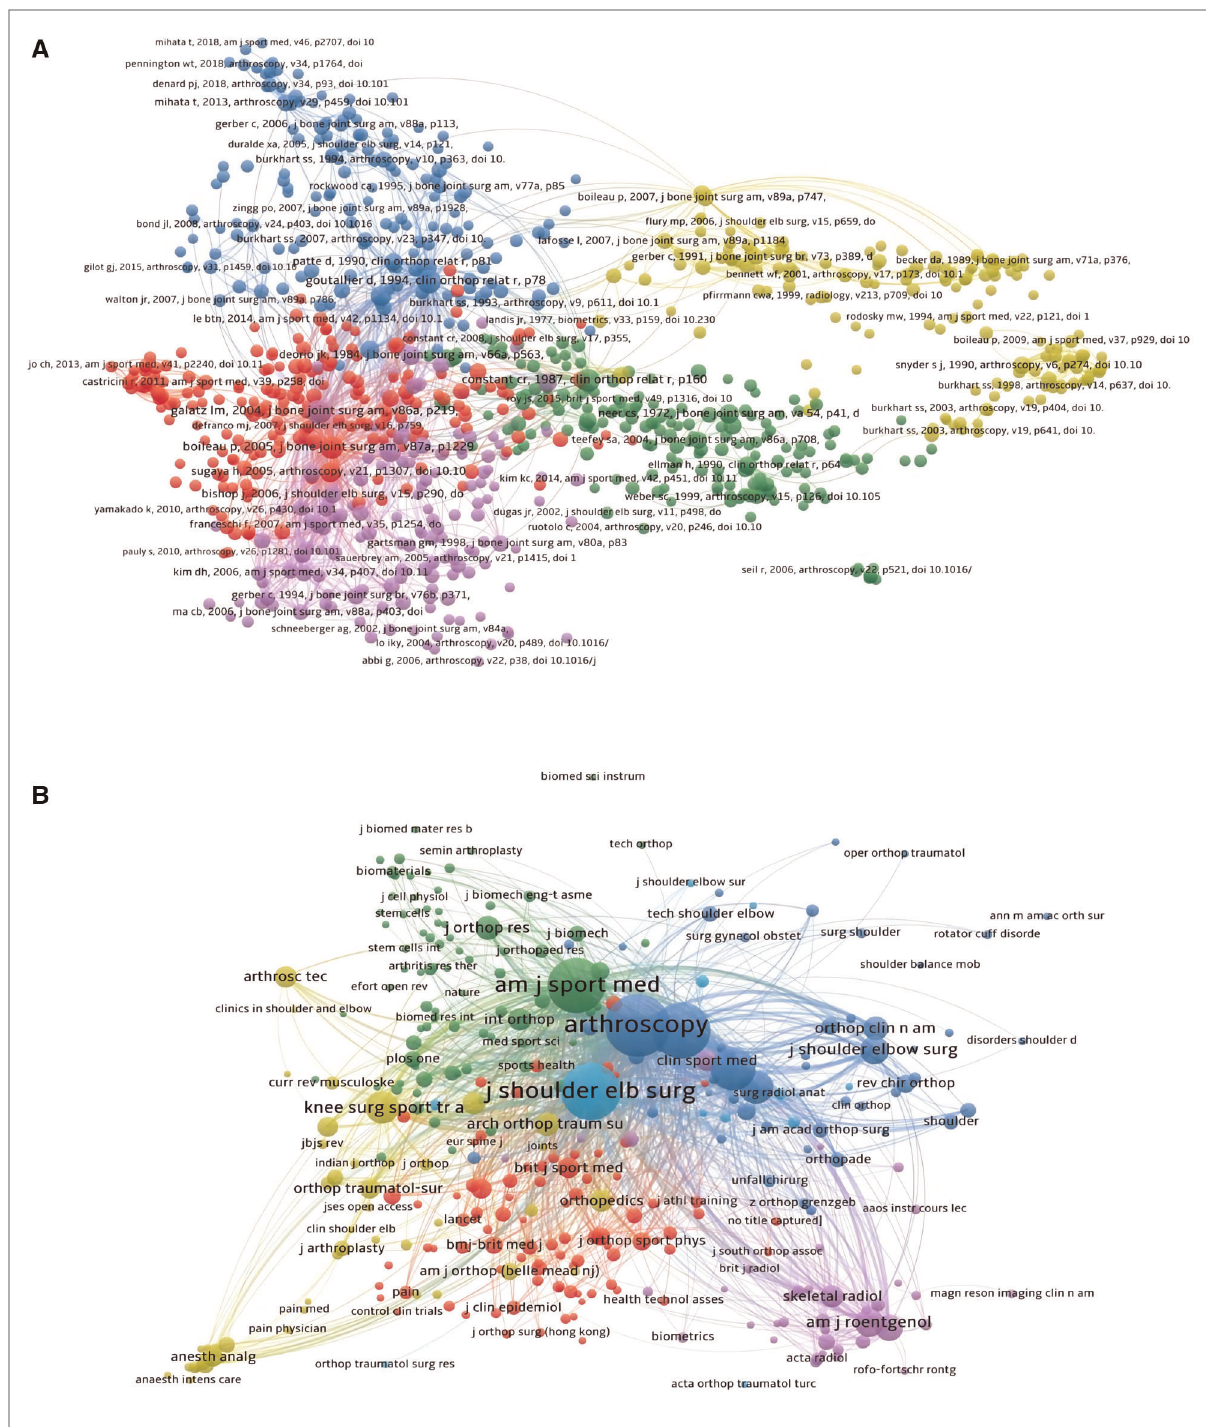
FIGURE 10 Co-citation analysis of publications and journals (analysis based on the arthroscopic therapy of rotatorcuff diseases related publications from 2002 to 2021). ( A ) Mapping of the 850 identi fi ed the most relevant publications. ( B ) Mapping of the 321 identi fi ed the most relevant